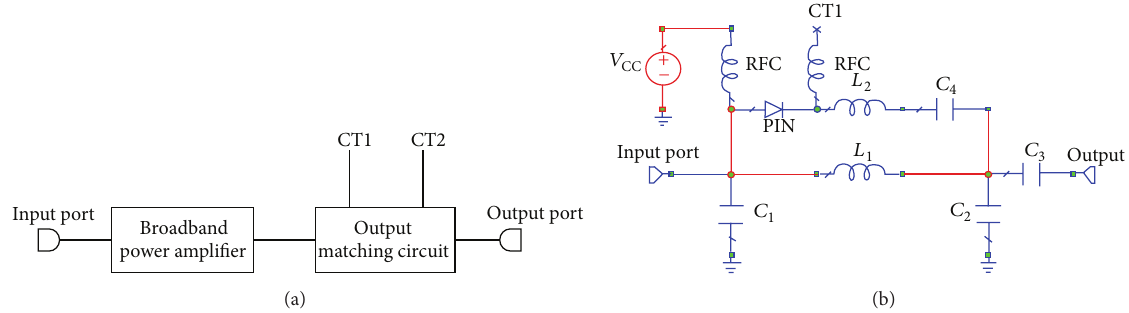
Figure 7: (a) Proposed broadband power amplifier module; (b) schematic of the novel reconfigurable output matching circuit [11].